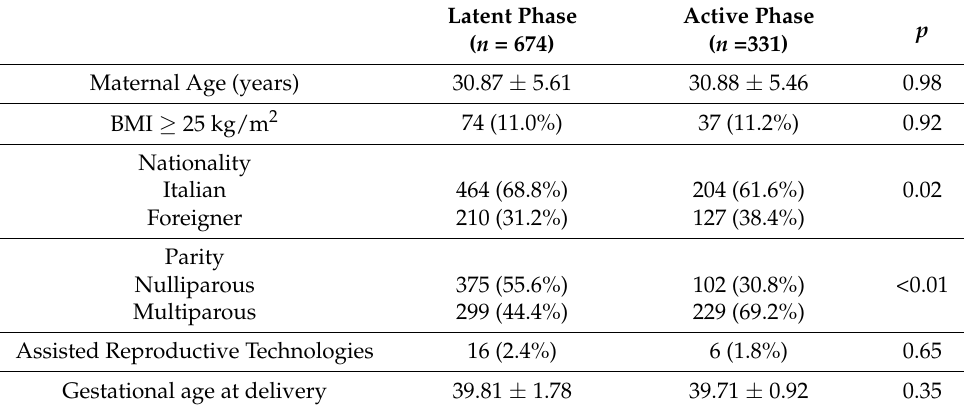
Table 1. Comparison of demographic and obstetric characteristics of low-risk women admitted in active or latent phase labor at